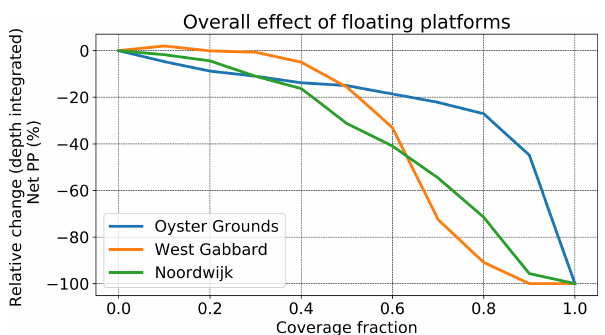
Figure 3. Relative change against the reference of net primary pro- duction with increasing coverage under the overall effect of floating platforms for the three locations of the experiment.